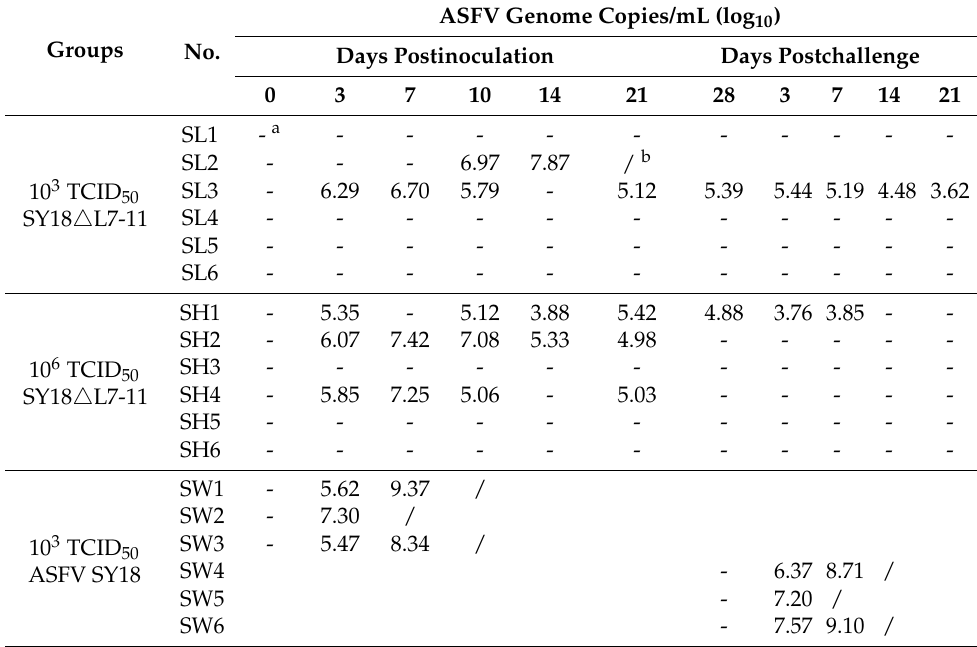
Groups Table 1. Virus genome copies in blood samples of swine after inoculation or challenge.